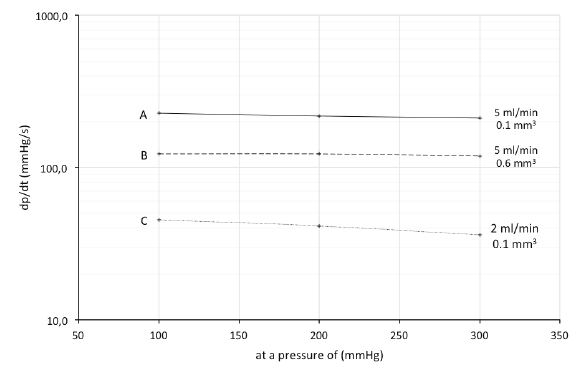
Figure 2: Slew rate dp/dt depended on gas-flow rate and dead space (logarithmically scaled y-axis) A – flow rate 5 ml/min, transducer dead space about 0.1 mm 3 , B – flow rate 5 ml/min, transducer + catheter channel (diameter 0.2 mm, length 166 cm), dead space